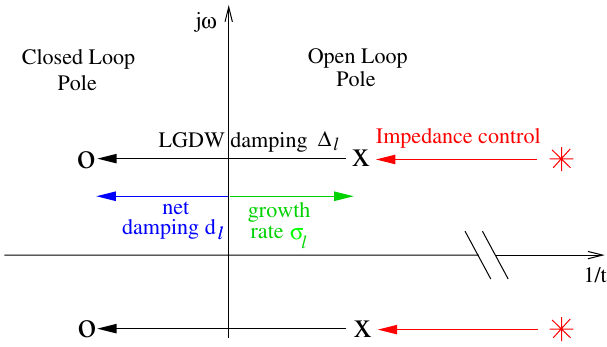
FIG. 3. (Color) Representation of the closed loop pole of the most unstable beam mode ( (cid:6) ), the open loop pole (x) and the open loop pole in the absence of impedance control feedback (red (cid:5)